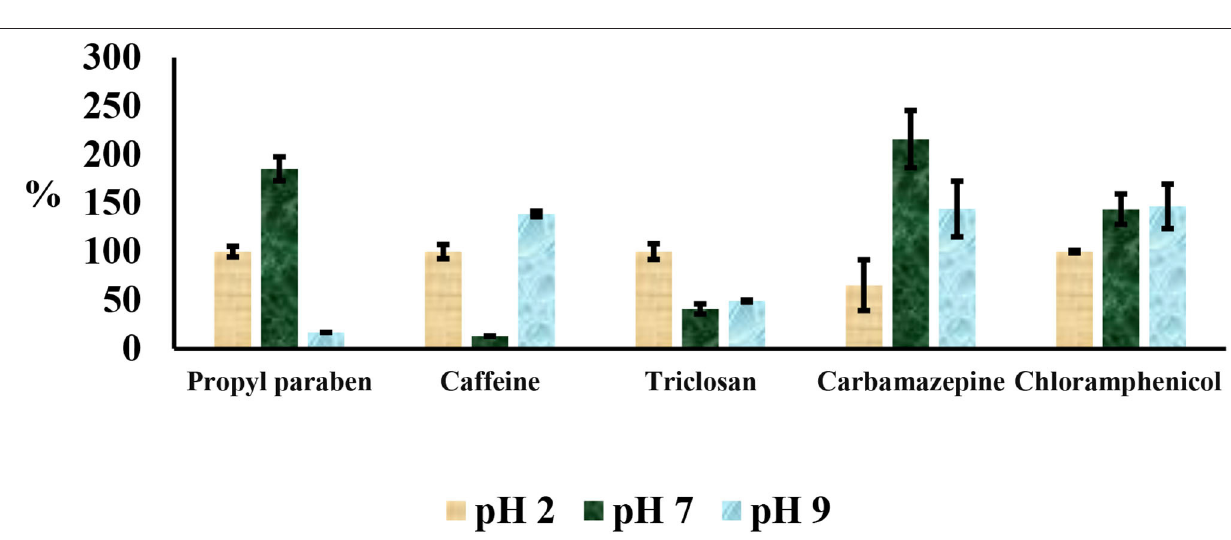
Figure 4 . Ethyl acetate:acetone (1:1), acetonitrile and methanol were used as elution solvents. These solvents are normally employed in the extraction of PCPPs because of their polarity and ability to dissolve all the selected drugs (Gumbi et al., 2017a,b, 2019). Spiked double distilled water (10 µ g L − 1 ), aliquots of 200 ml, adjusted to pH 2, 7, and 9 were